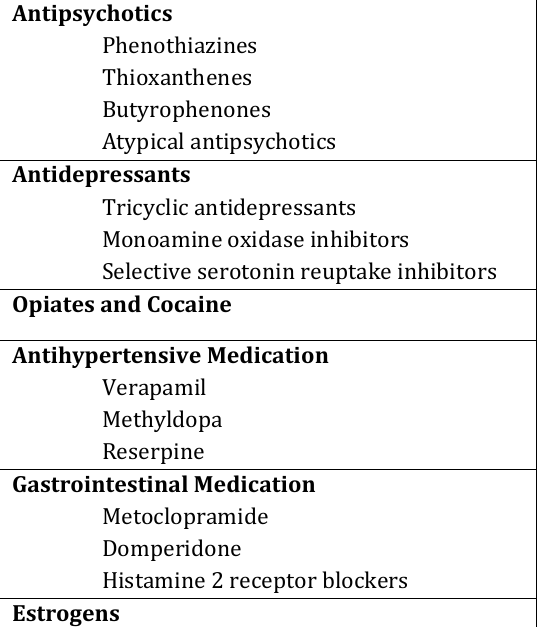
Table 2. Medication causing